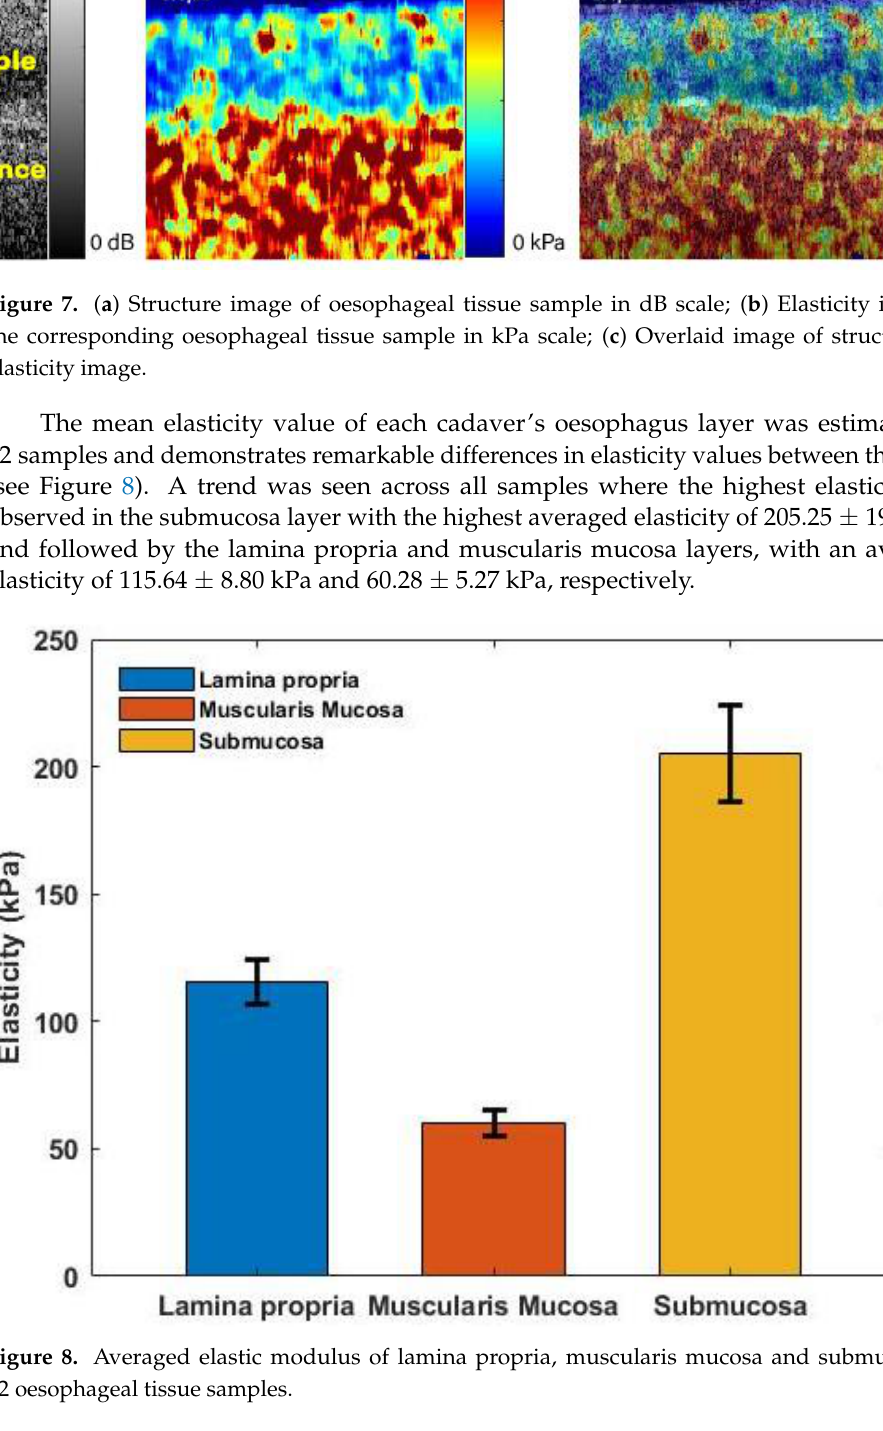
Figure 8. Averaged elastic modulus of lamina propria, muscularis mucosa and submucosa for 52 oesophageal tissue samples.